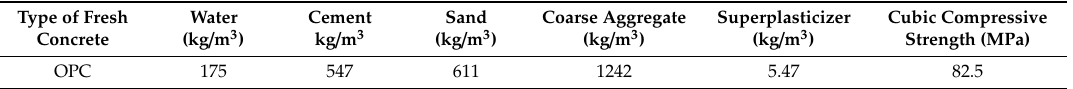
Table 2. Mix proportions and compressive strength of fresh cement concrete.